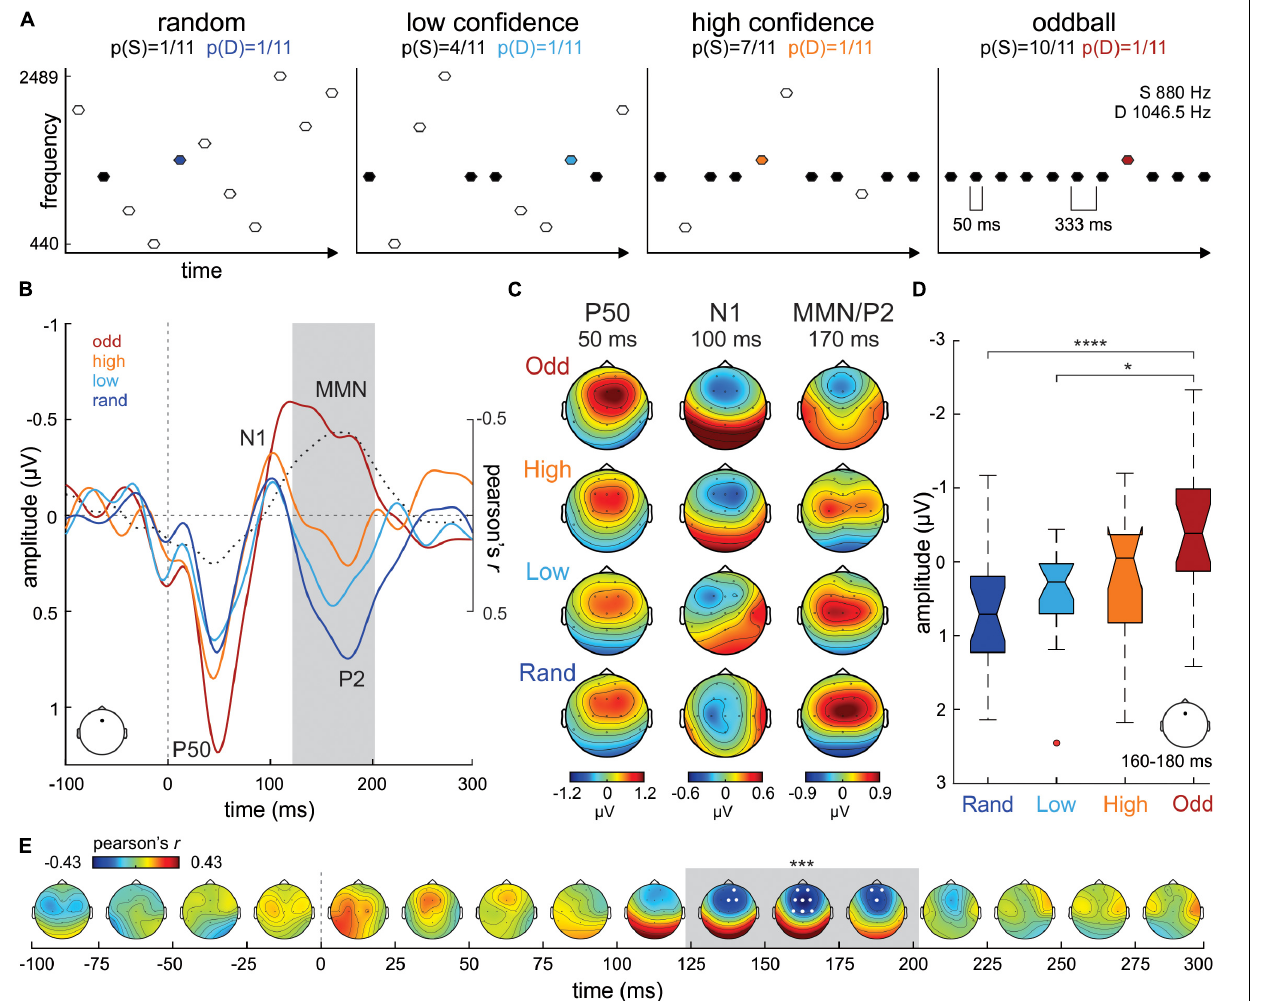
FIGURE 1 | (A) Experimental design. (B) ERP waveforms from Fz electrode evoked to D stimuli in the Oddball (odd; dark red ), High confidence (high; orange ), Low confidence (low; cyan ) and Random (rand; dark blue ) conditions. Correlation values (Pearson’s r ) between S tone probability and D tone ERP amplitudes at each time point are plotted in a dotted black line. The gray shaded area marks the temporal extent of the significant cluster of correlation values (122–202 ms). (C) P50, N1 and MMN/P2 scalp potential distribution maps per condition separately. (D) Boxplot series illustrating the distribution of mean amplitude ERP values extracted from Fz around the maximum correlation peak (170 ms) in our sample of participants, separately per condition. The boxplots represent the median value (middle line), the interquartile range (full box) and the extreme values (whiskers; outliers are plotted as separate dots). Significance of post hoc tests: **** p < 0.001; * p < 0.05. (E) Time-electrode evolution of Pearson’s r -values. The gray shaded area marks the temporal extent (122–202 ms) of the significant ( ***p < 0.005) cluster of correlation values, while the white dots (electrodes) denote its spatial